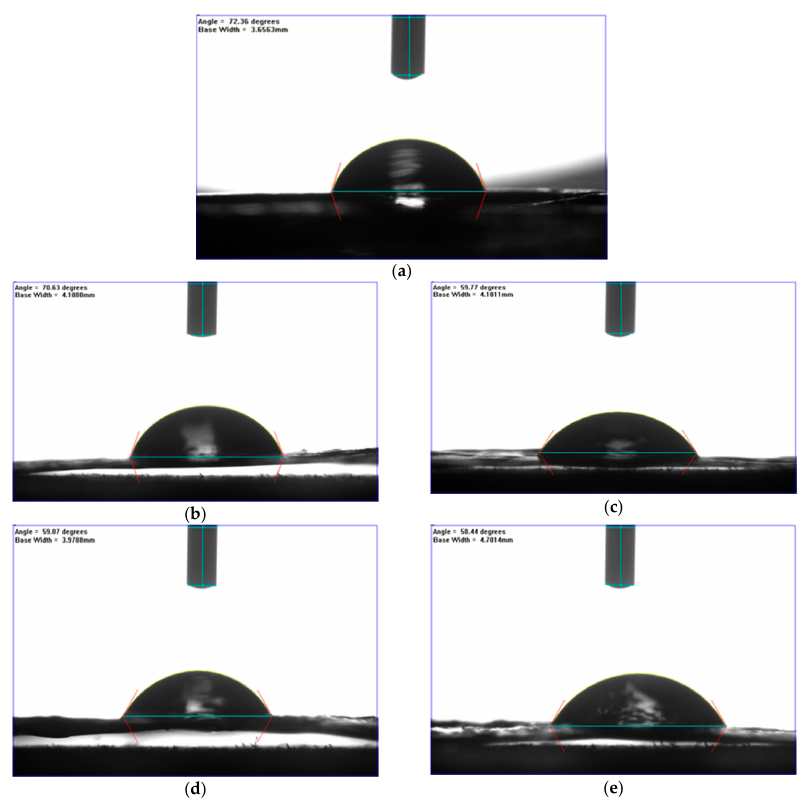
Figure 3. Water contact angles of: ( a ) PD-neat; ( b ) PDNC-I; ( c ) PDNC-II; ( d ) PDNW-I; and ( e ) PDNW-II membranes.